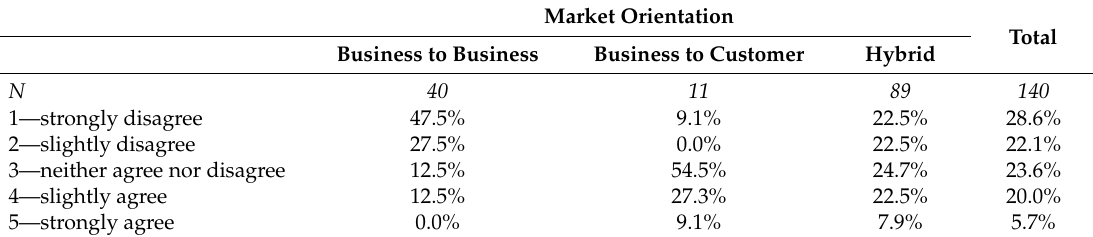
Table 1. Use of social customer relationship management (SCRM) to support marketing according to market